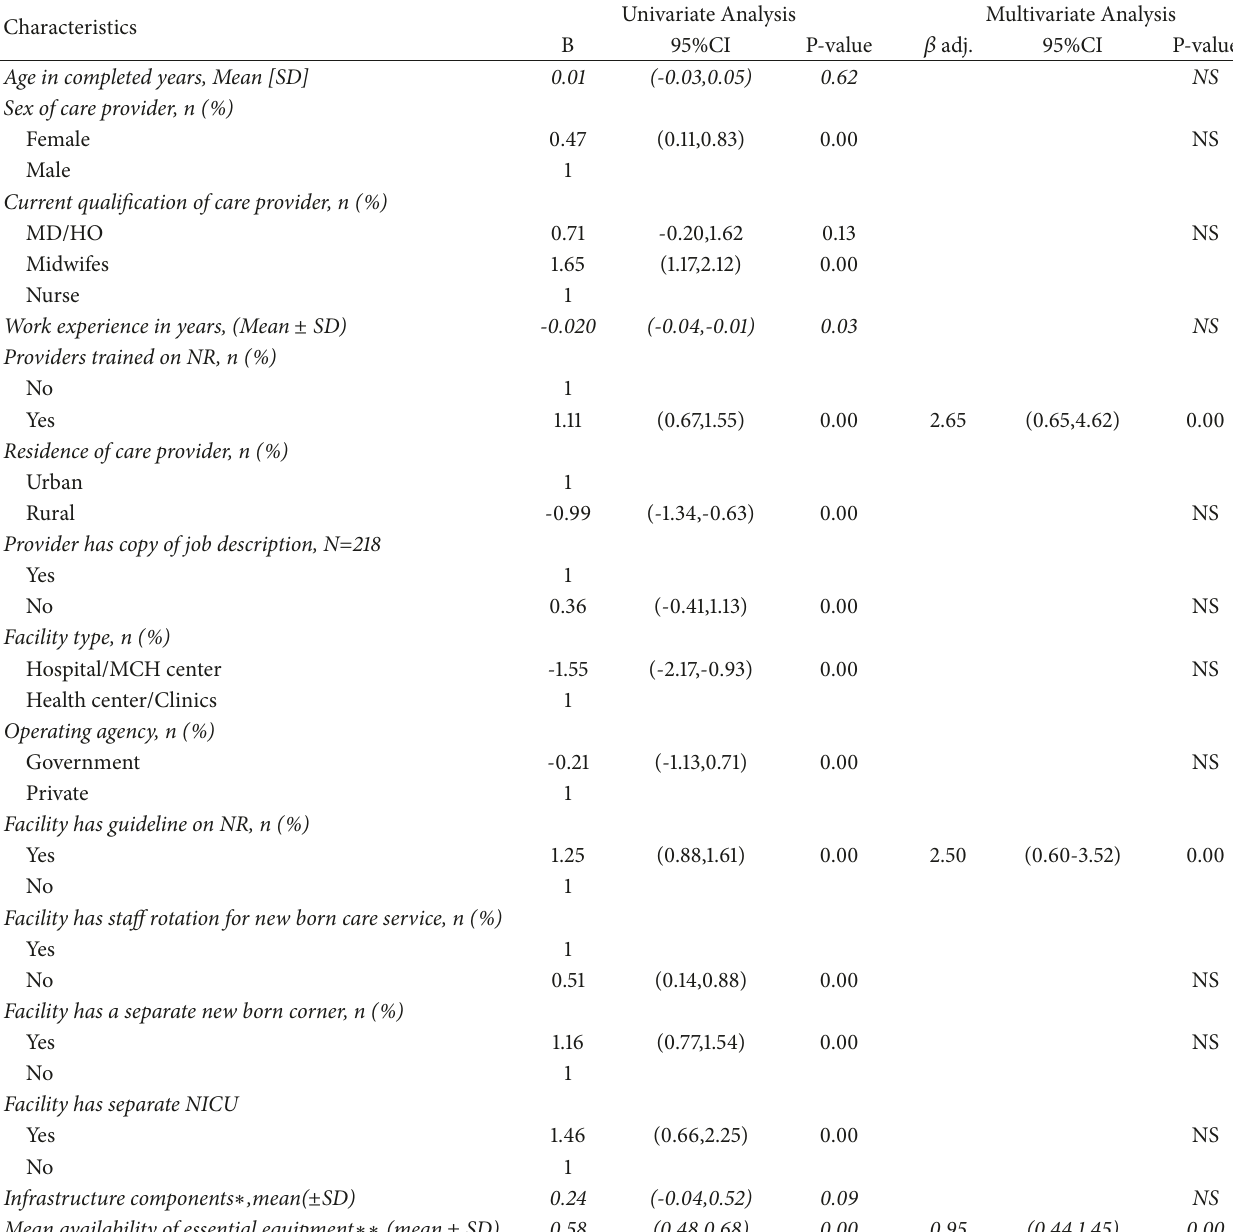
Table 3: Linear regression analysis of predictors of knowledge of NR among health care